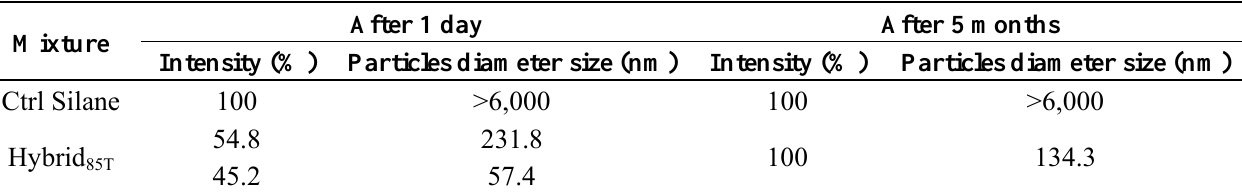
Table 1. Results from DLS analysis performed on uncured Ctrl Silane and Hybrid